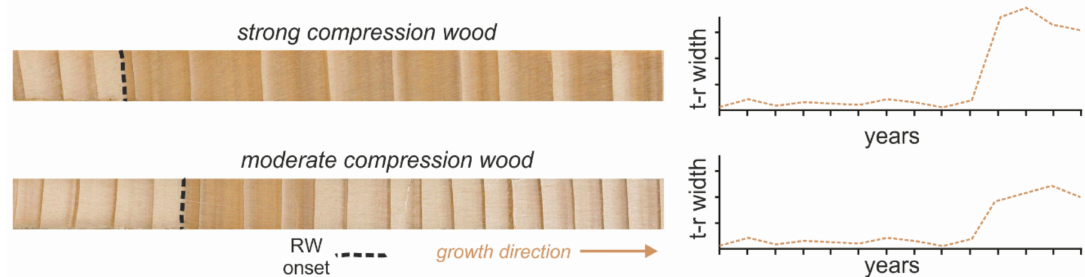
Figure 3. The view of compression wood in tree-ring series of coniferous trees including the increment curves with visible associated growth